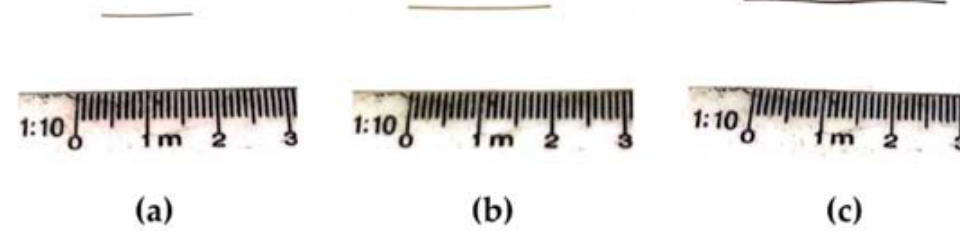
Figure 2. The microstreel fibers used in this study: ( a ) F1, ( b ) F2, and ( c ) F3. Table 3. Physicomechanical properties of the fibers.